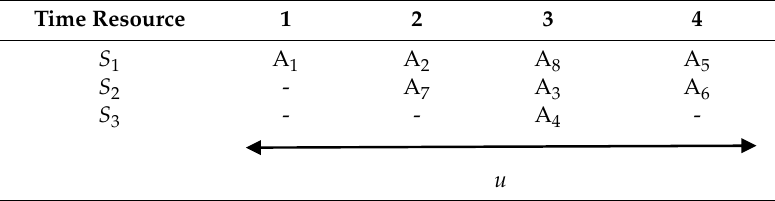
Table 2. Determined parallel plan based on the result of GSA execution.